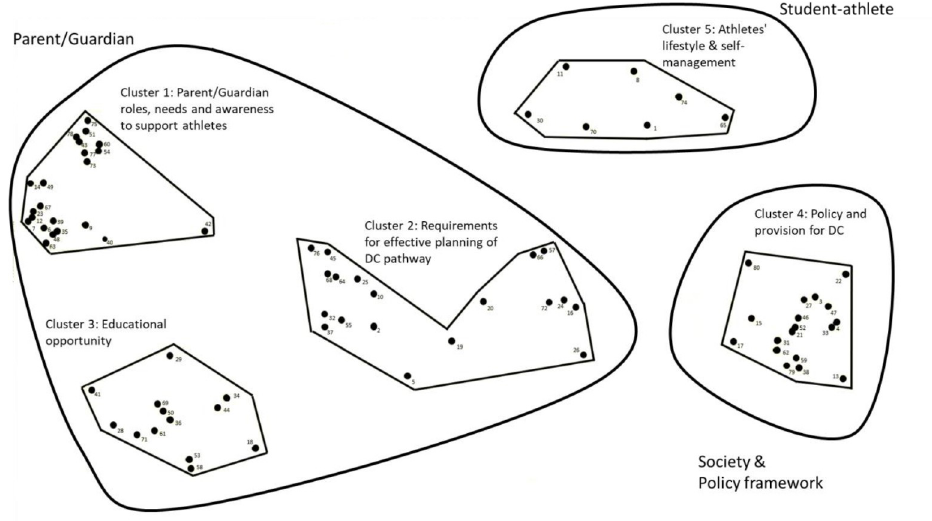
Fig 2. Five-cluster map within the three main areas Parent/Guardian (Cluster 1: Parent/Guardian roles, needs and awareness to support athletes; Cluster 2: Requirements for effective planning of dual career pathway; and Cluster 3: Educational opportunity), society and policy framework (Cluster 4: Policy and provision for dual career), and student-athlete (Cluster 5: Athletes’ lifestyle & self-management).